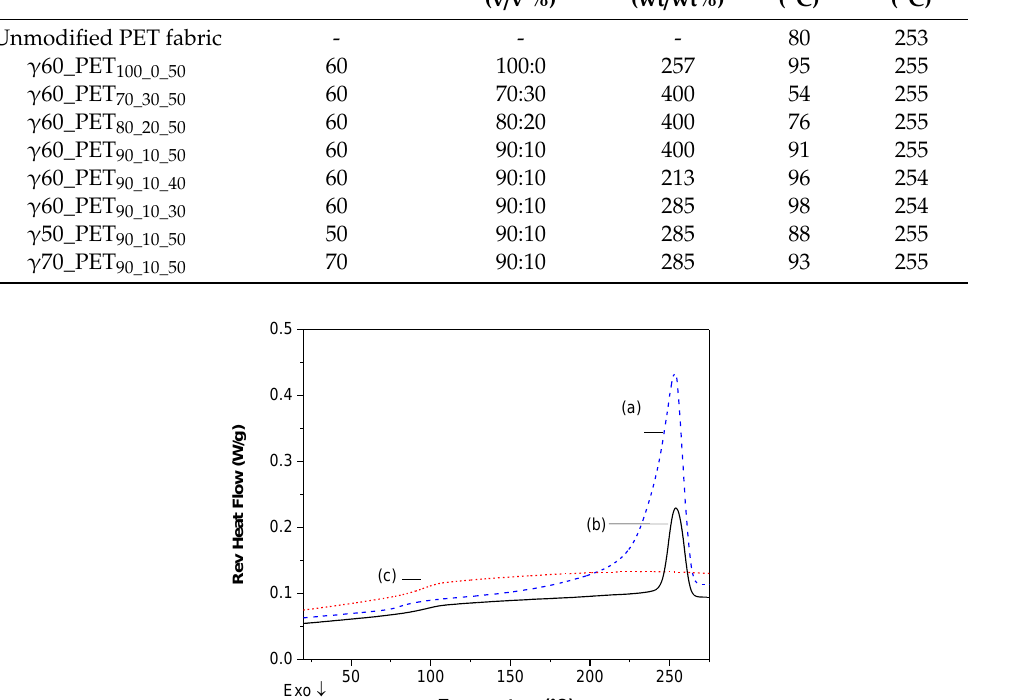
Table 4. Results by DSC for PET fabrics modified obtained by the direct gamma irradiation method. Figure 5. DSC curves of ( a ) PET, ( b ) γ60 PET 90:10:30 400% hydrogel, and ( c ) γ60 poly(HEMA -co- PEGMA) hydrogel. Sample